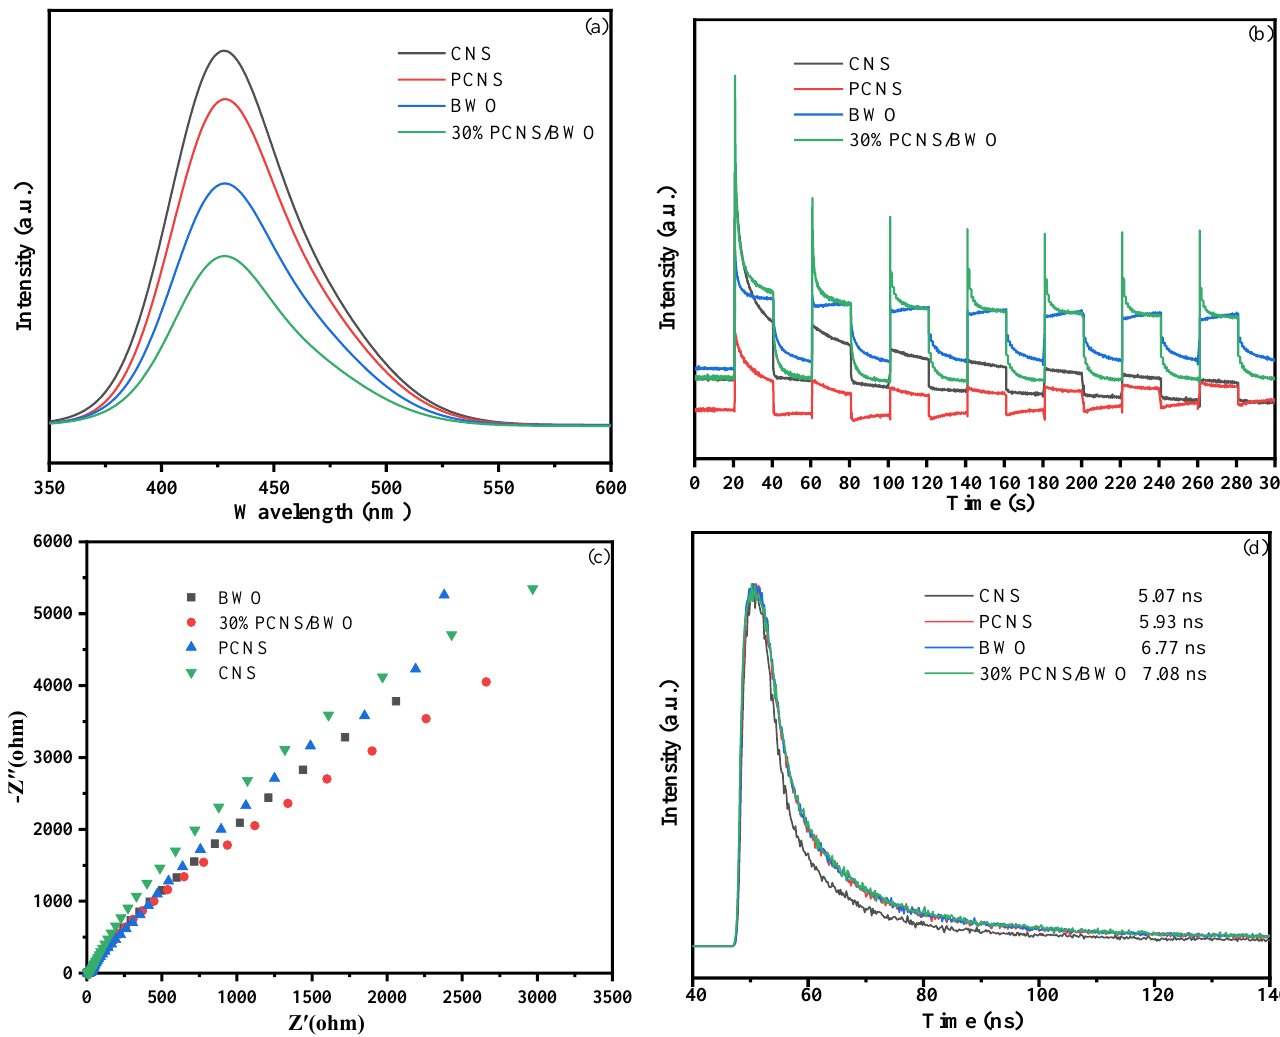
Figure 8. ( a ) Photoluminescence spectra, ( b ) i – t curves, ( c ) Nyquist plots from EIS data, and ( d ) fluorescence decay curves of CNS, PCNS, BWO, and 30% PCNS/BWO. ( d ) fluorescence decay curves of CNS, PCNS, BWO, and 30%